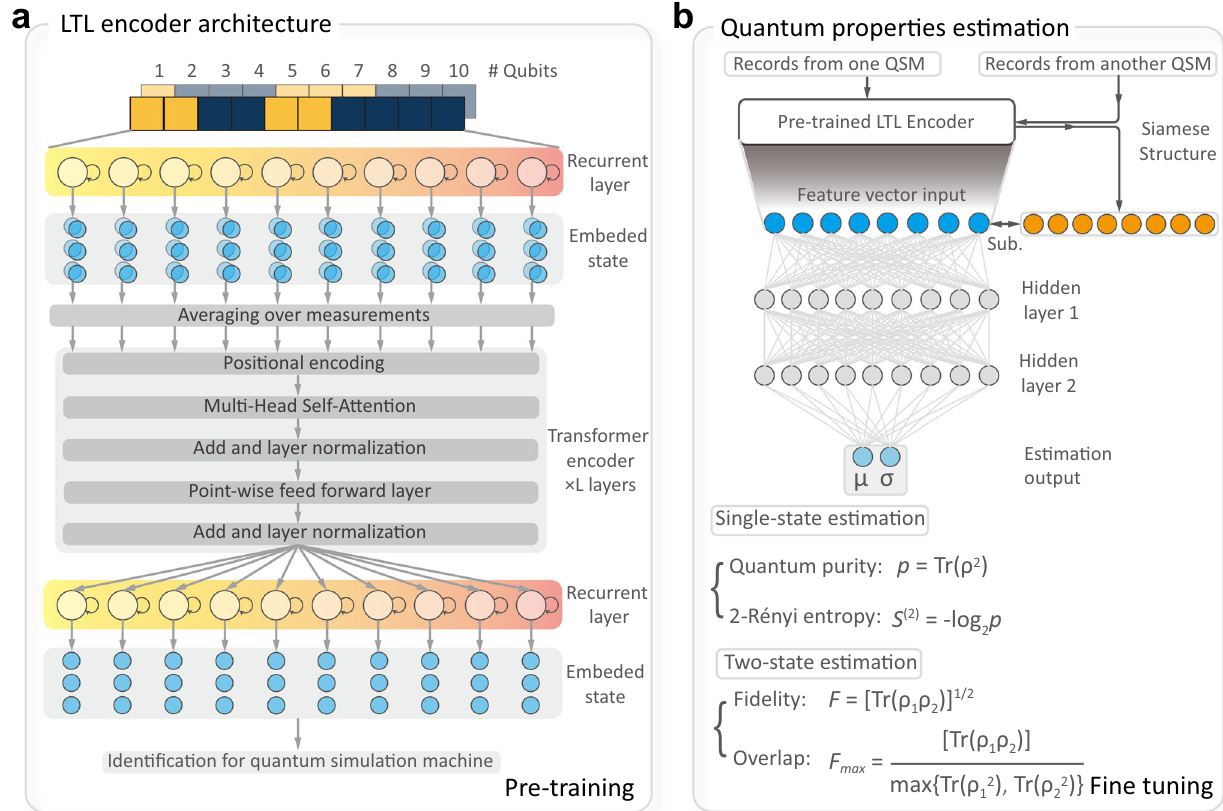
Fig. 7 The backbone of the LSTM-Transformer-LSTM (LTL) model. a The LTL encoder works as follows: raw measurement records are split into single-shot records and each single-shot record is embedded through a recurrent layer. Then all embedded states are aggregated and averaged to generate a complete embedding. Subsequently, the embedding is processed via the L transformer encoder layer to further extract the latent pattern. Finally, the output of the transformer layer is fed into a recurrent layer to obtain the fi nal embedding used for quantum downstream tasks. b The quantum properties such as purity and fi delity can be estimated by fi rstly encoding the raw records into the representative high-dimensional embedding and then passing the embedding into an arti fi cial neural network (ANN) to accomplish the estimation. The two-state estimation requires two records of QSMs from different locations and